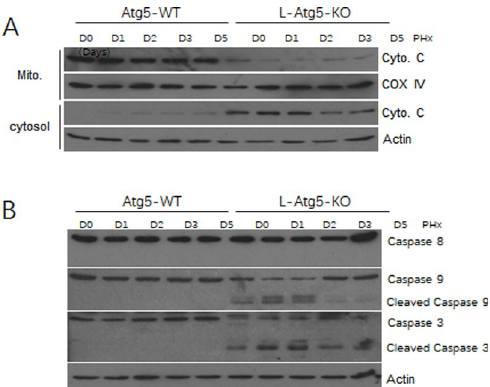
Fig 5. The intrinsic apoptotic pathway was activated in the liver of L-Atg5-KO mice after PHx. (A) Immunoblot analysis of caspases, cytochrome C, which is a mitochondria membrane protein [31], COX IV was used as a loading control for the mitochondrial fraction (Mito). Actin was used as the loading control for the cytosolic fraction. (B) Immunoblot analysis of caspase-8, caspase-9 and caspase-3 levels in the liver tissue of Atg5-WT and L-Atg5-KO mice. Actin was used as a loading